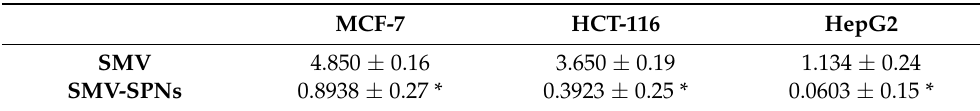
Figure 6. Transmission electron microscope micrograph of the optimized SMV-SPNs. Abbreviations: SMV, simvastatin; SPNs; spanlastics. Table 4. Calculated IC 50 values ( µ M) of SMV and SMV-SPNs in human breast, colon, and hepatic cancer cell